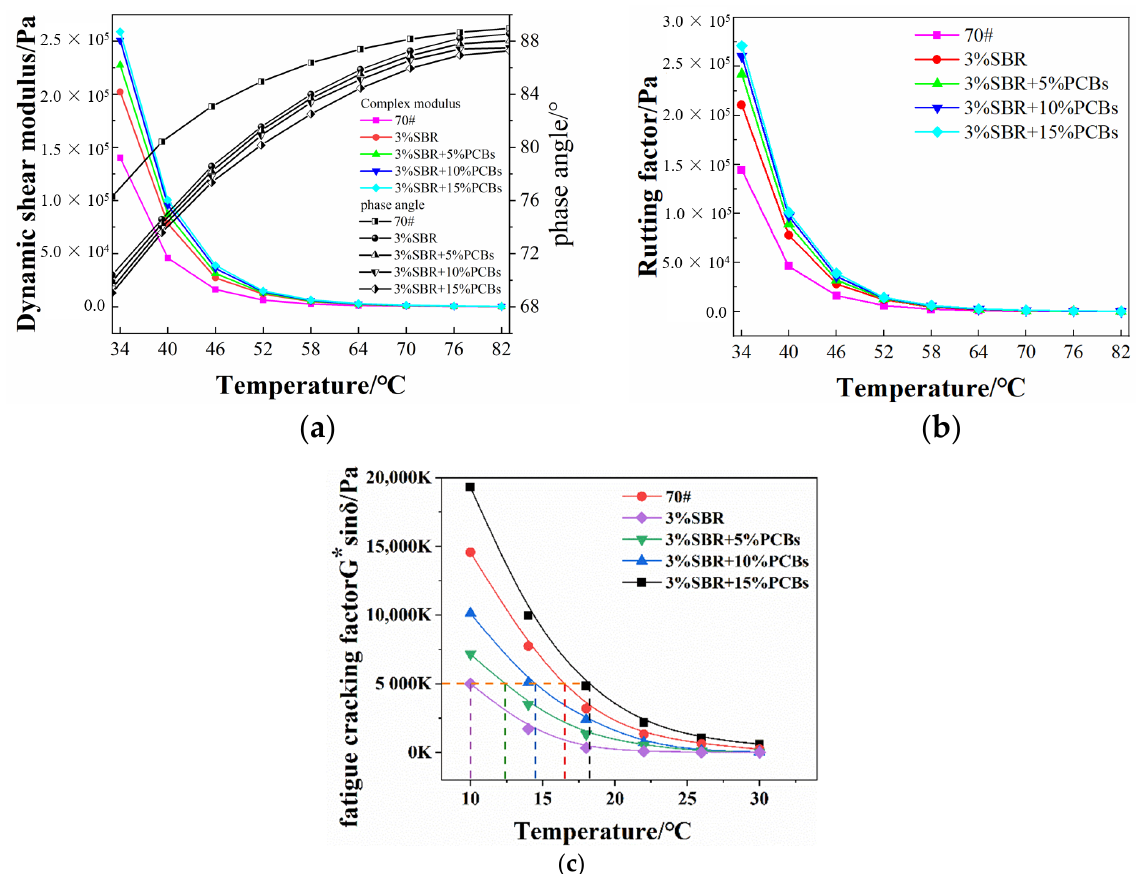
Figure 4. The results of temperature sweep test: ( a ) |G*| and phase angle; ( b ) rutting factor ( c ) fatigue cracking